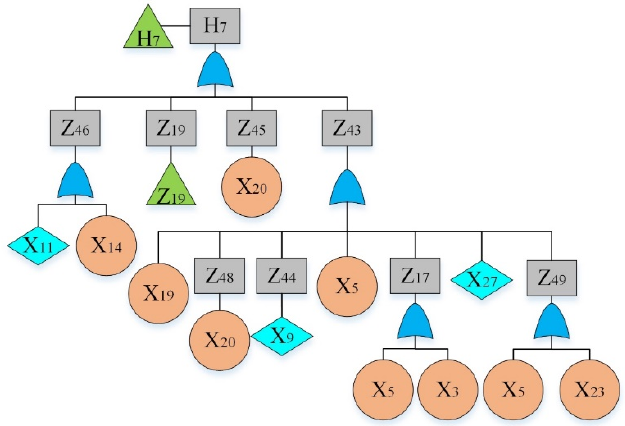
Figure 8. Fault tree of a hydraulic system: sub-tree VI.